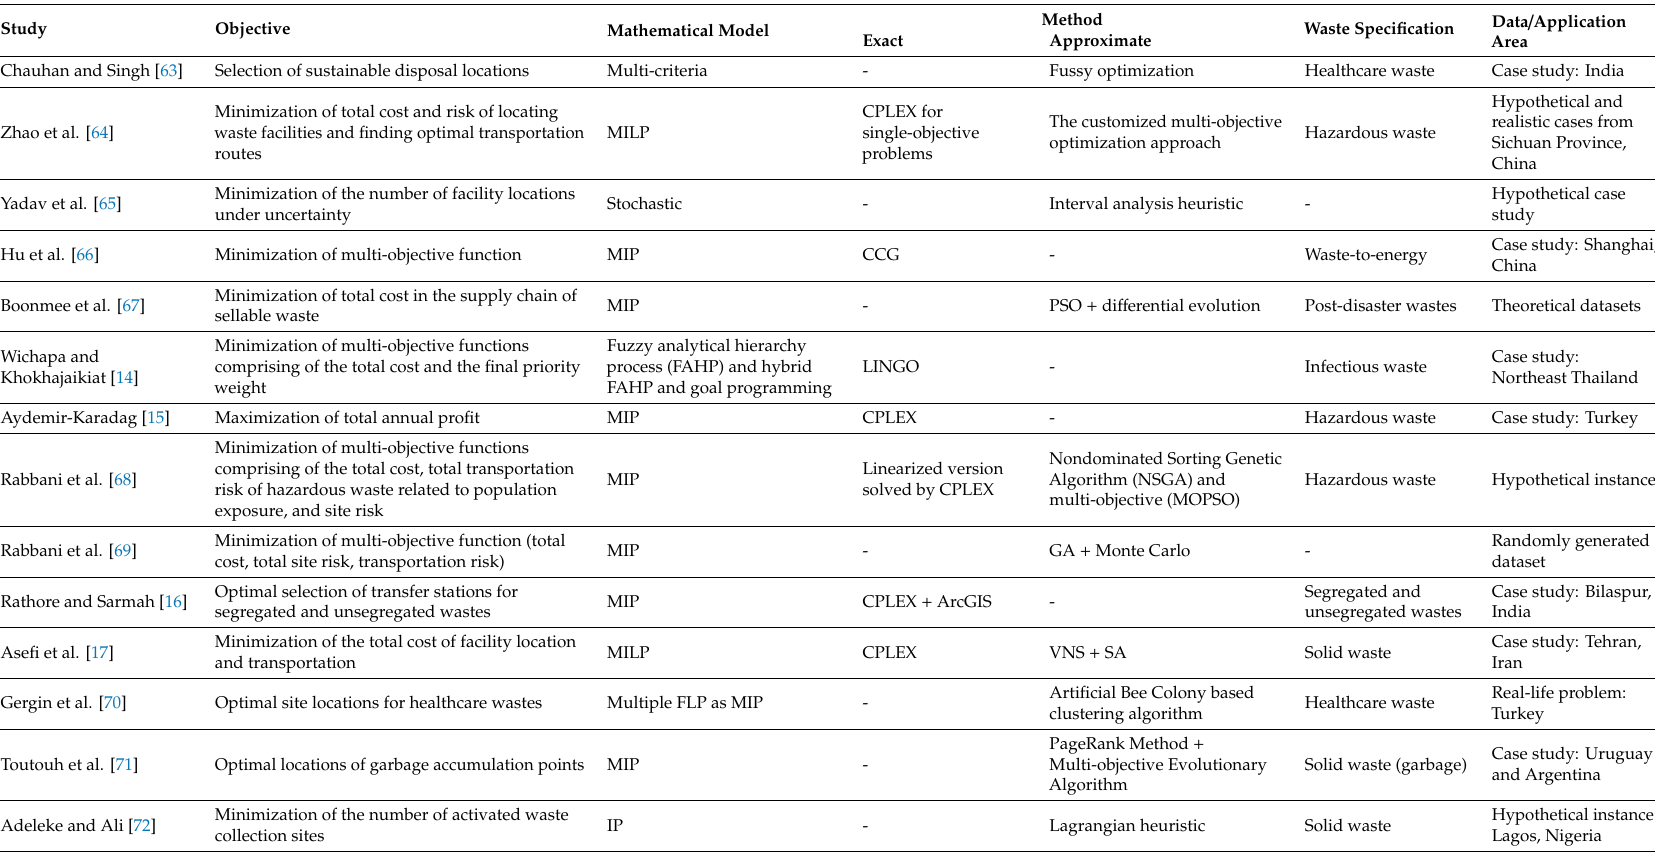
Table 1. Some recent studies on the applications of facility location problems (FLPs) to waste